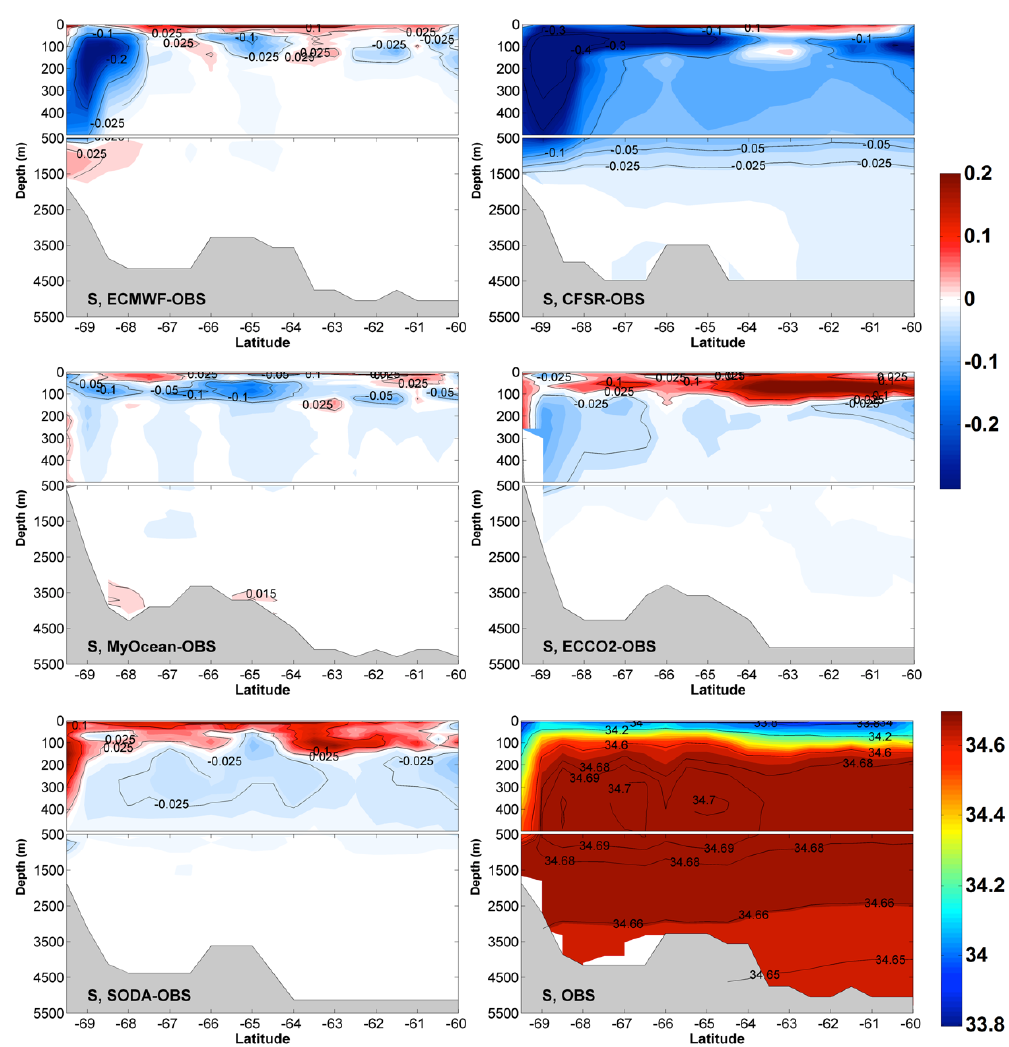
Figure 6. Section WOCE A12. Representation of the time-averaged in situ data and the differences between the reanalyzed and observed data for S . ECMWF, CFSR, MyOcean, ECCO2, and SODA results are indicated in each figure. The upper 500m is expanded to show more detail.